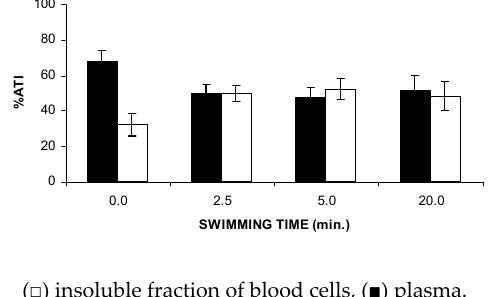
Figure 4. Effect of the forced swimming (FS) on the distribution of 99m Tc between the cellular and plasma compartments. Wistar rats were submitted to FS, blood samples were withdrawn, and the labeling of blood constituents with the 99m Tc procedure was carried out. Blood cells and plasma were separated by centrifugation. The radioactivity in blood cells and plasma was measured and the percentage of 99m Tc incorporated (%ATI) was calculated.